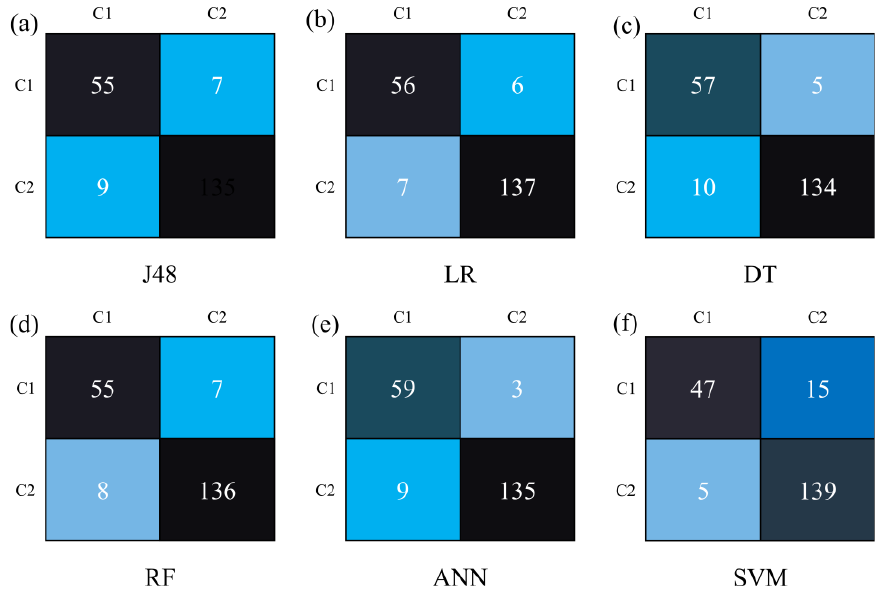
Figure 7. Boxplot of the clustering of means for F-score regarding the machine learning models tested (J48 decision tree algorithm–J48, logistic regression–LR, REPTree decision tree algorithm–DT, random forest–RF, multilayer perceptron artificial neural network–ANN, and support vector machine–SVM). Means followed by the same letters do not differ by the Scott–Knott test at 5% probability.